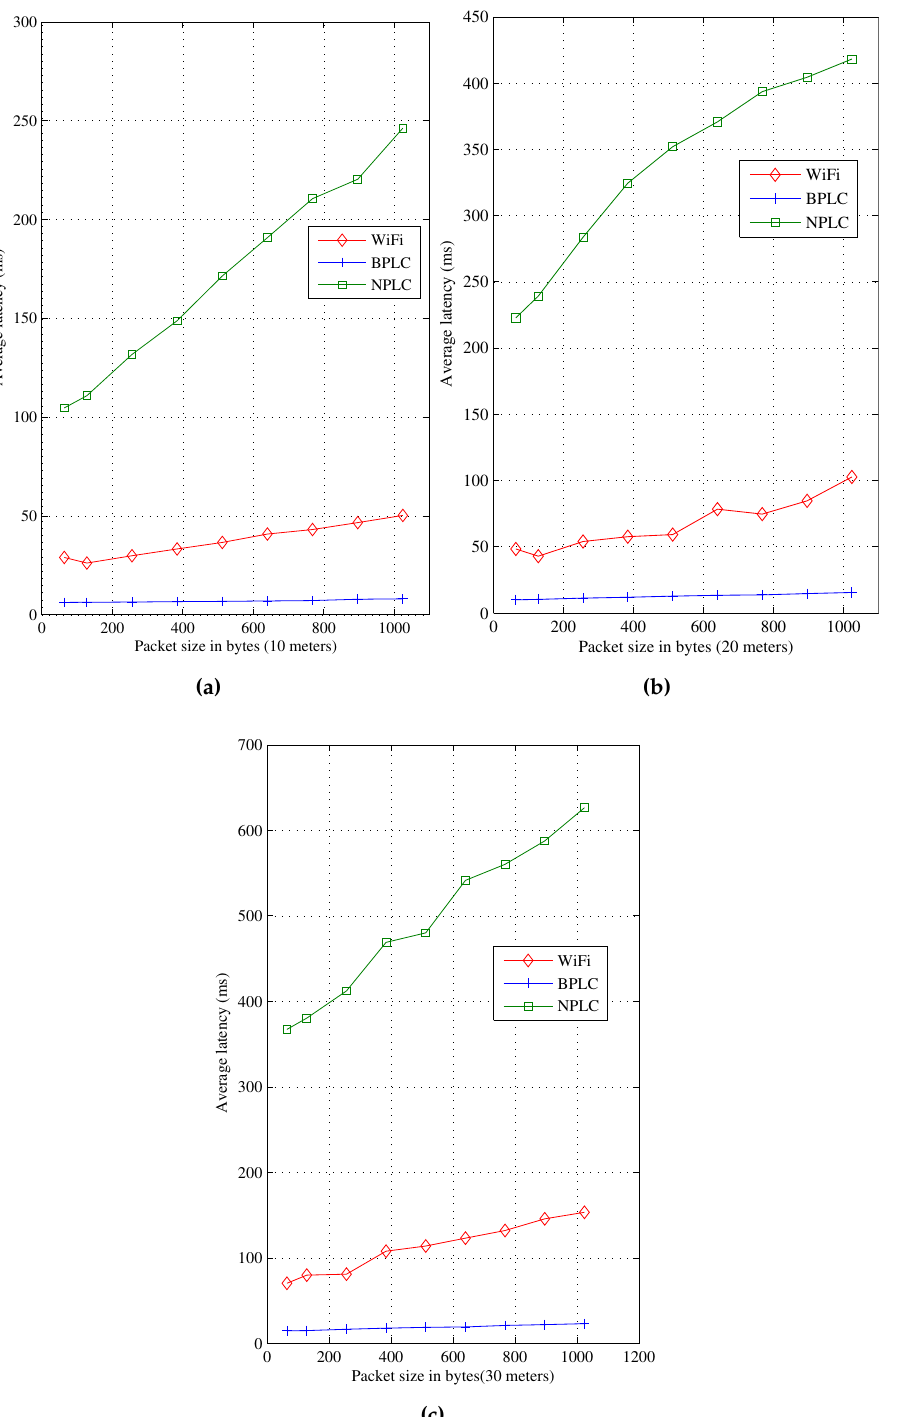
Figure 9. Variation of metering round-trip delay with application size. ( a ) 10 smart meters; ( b ) 20 smart meters; ( c ) 30 smart